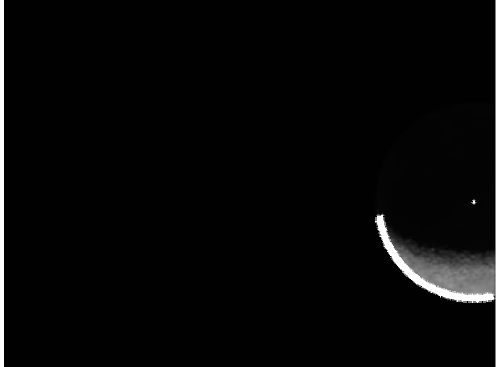
Figure 14. Example 2: Circular Sigmoid Function (CSF)-LS final estimation (data in pixel). Center (white mark) inside the image. Row center: 189.2105 ( ∆ r = − 0 . 12759 ). Column center: 437.1483 ( ∆ c = 0 . 3611 ). Radius: 89.0247 ( ∆ R = − 0 . 0064852 ).